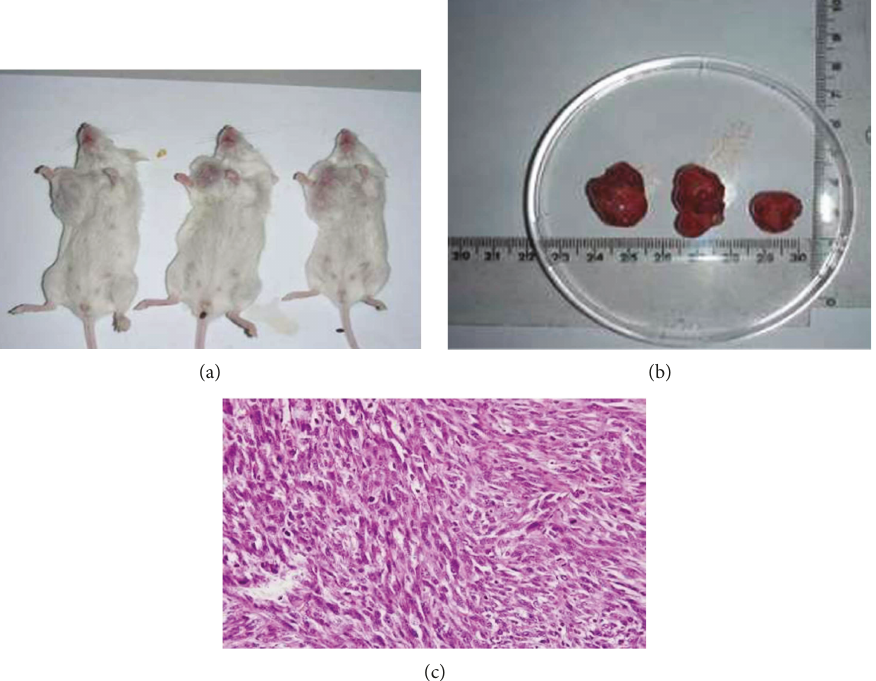
Figure 3: Tumorigenesis of malignant transformation of Balb/c 3T3 cells in SCID mice. (a) SCID mouse group injected with transformed Balb/c 3T3 cells. (b) Tumor growth in SCID mice. (c) Pathological section of tumor tissue stained with